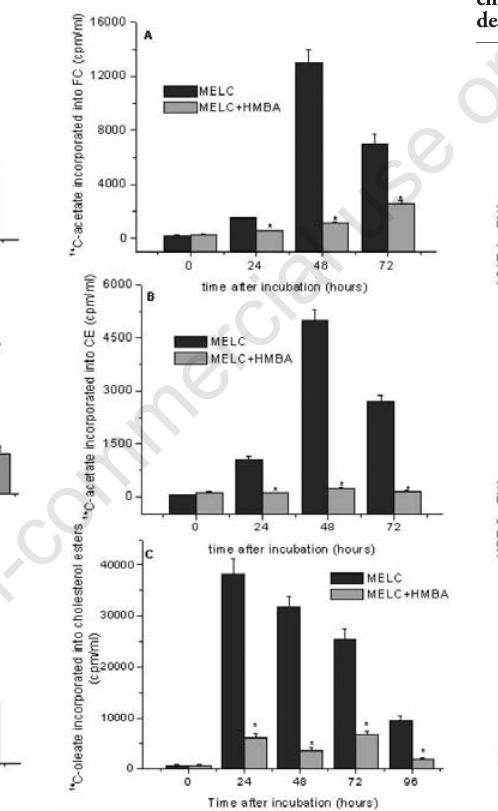
Figure 2. Time course of 14 C-acetate incor- porated into A) free cholesterol, B) coles- terol esters and C) 14C-oleate incorpora- tion into Colesterol Esters of murine ery- throleukemia cells (MELC) in presence or absence of hexamethylene bisacetamide (HMBA). MELC cells were seeded at a den- sity of 1 ¥ 10 5 cells/mL and stimulated to growth by adding 10% FCS 14 C-acetate and 14 C-oleate were added 3 h before each time point. MELC were harvested every 24 h for a total period of 96 h. Data are mean±Standard Error of three independent experiments, each performed in triplicate. *Indicates statistically significant (P<0.05) compared with MELC.